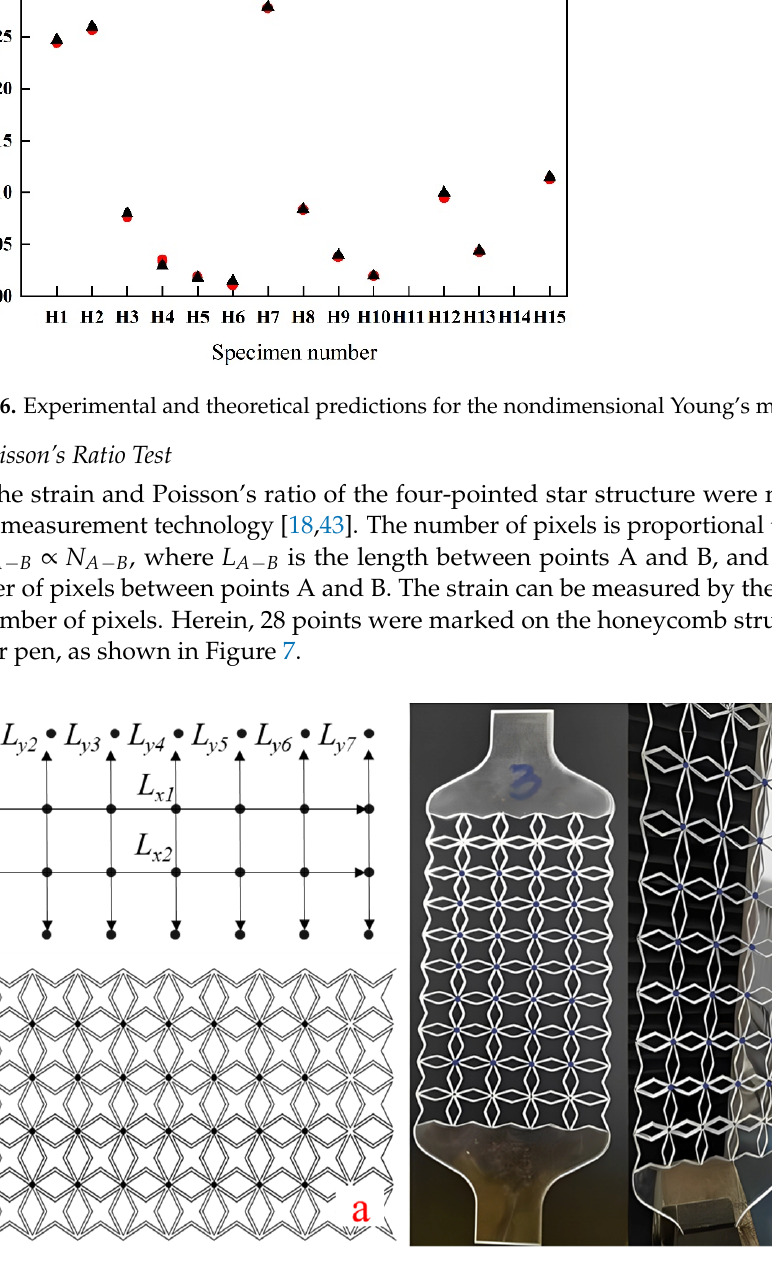
Figure 7. Poisson’s ratio measurement. ( a ) schematic diagram of marked points, ( b ) test sample.